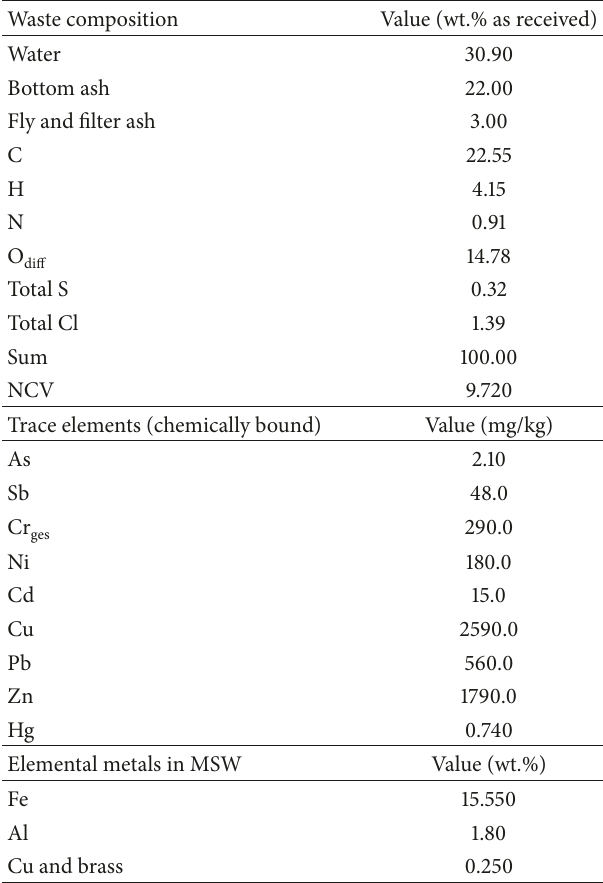
Table 1: Waste composition as input for both WtE plants.